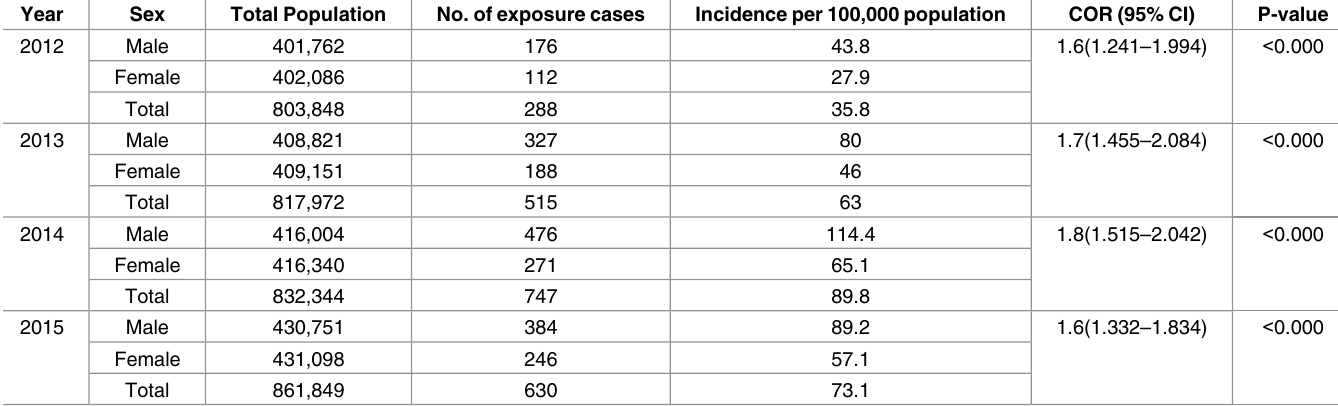
Table 2. Incidence of human rabies exposure casesregistered and followed up their PEP at Suhul hospital in 2012, 2013, 2014 and 2015. Year Sex Female